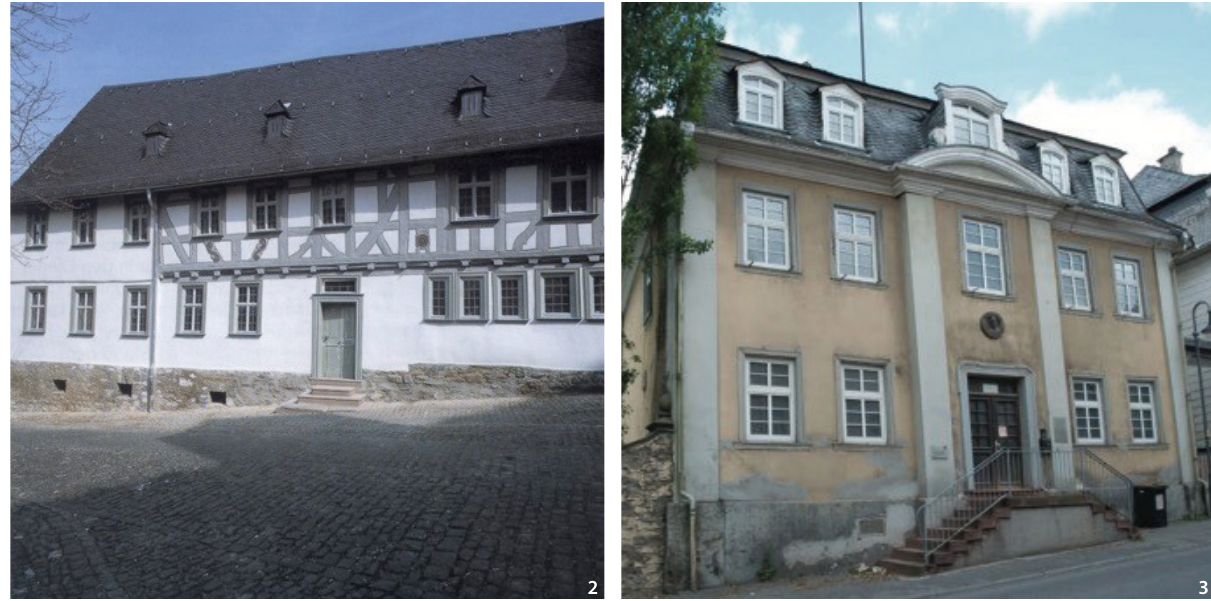
Figure 2 20 years after restoration, the Lottehaus in Wetzlar received the Hessian Monument Protection Award (Source: the author). Figure 3 Usingen fürstliches Beamtenhaus before restoration (Source: the